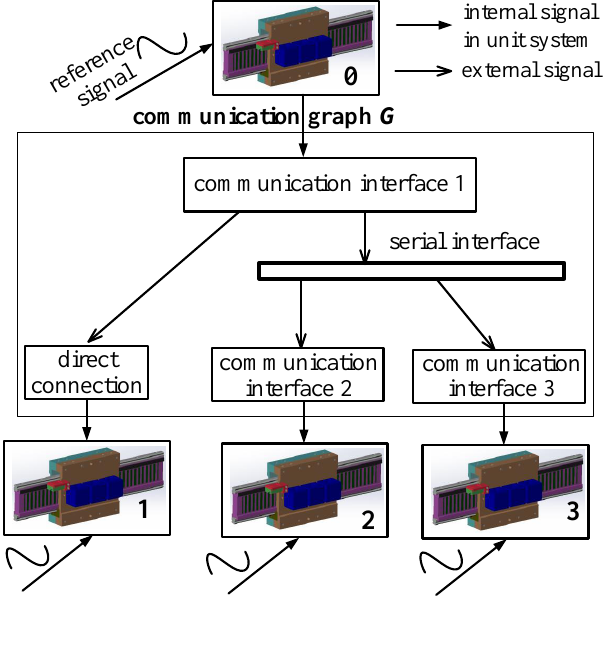
Figure 7. Hardware